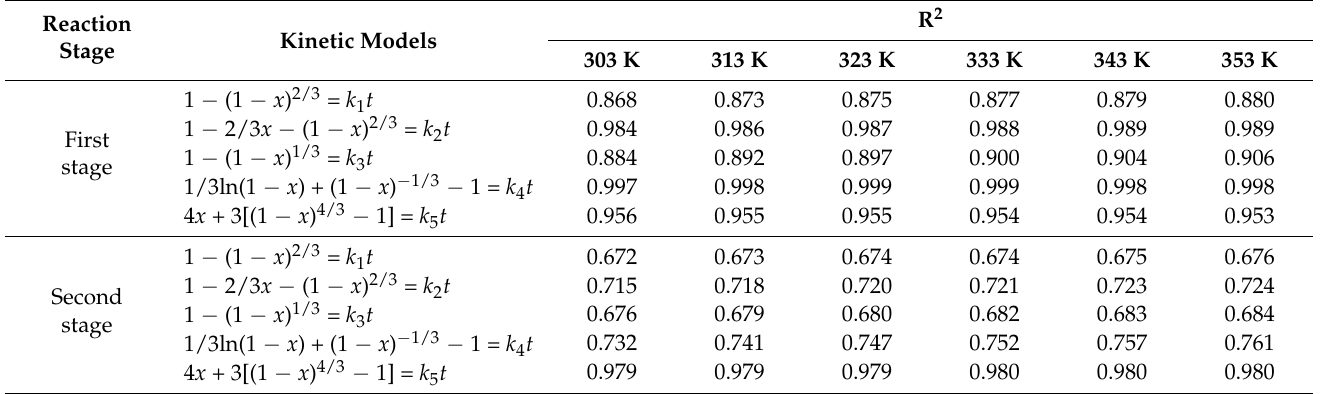
Table 6. Correlation coefficients (R 2 ) of various kinetic models with the experimental